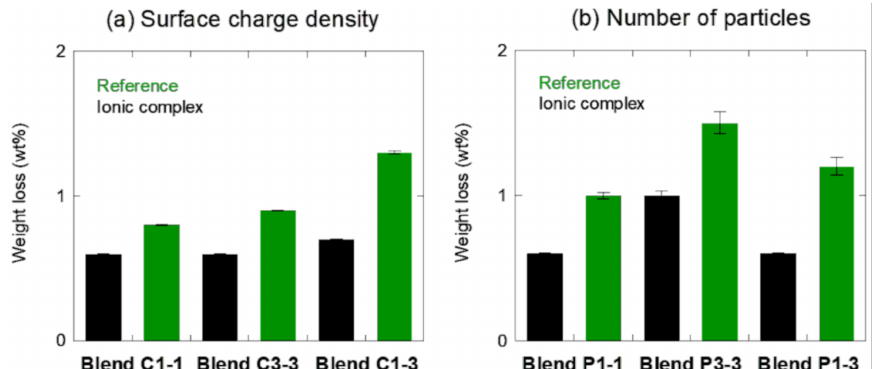
Figure 9. Weight loss (wt%) values after water uptake experiments for polymer blend films based on equal ( a ) surface charge density; and ( b ) number of